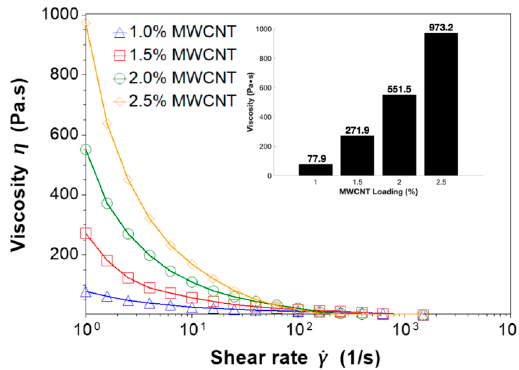
Figure 2. Viscosities of the nanocomposite prepolymer with multi-walled carbon nanotube (MWCNT) concentrations of 1.0 wt. %, 1.5 wt. %, 2.0 wt. %, and 2.5 wt. %.